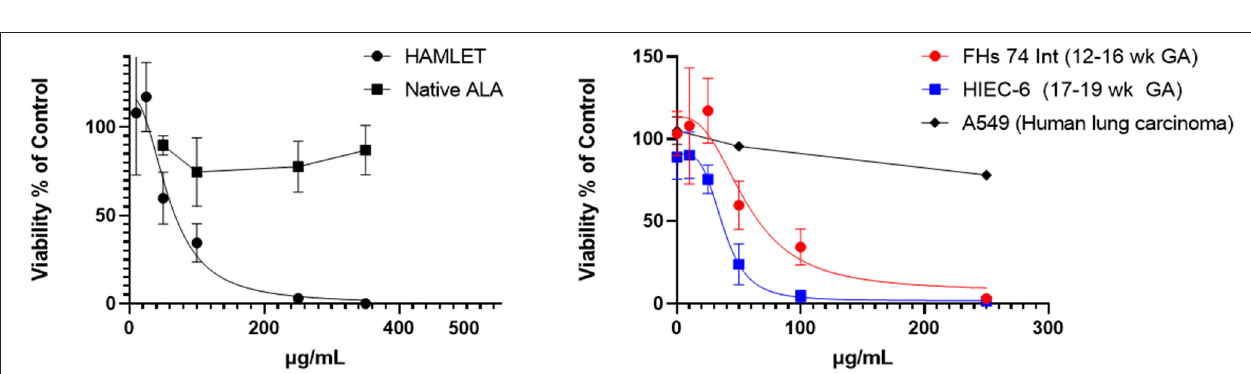
FIGURE 5 | Free oleic acid in casein vs. whey fractions in human milk. Milk ( n = 6) was skimmed, 1.0N HCl was added to adjust milk pH to 4.3. Acidified skimmed milk was centrifuged at 8000 × g for 10min to precipitate casein from whey layer. Separated proteins were pH corrected to 6.8 ± 0.1 pH in HBSS and analyzed for FFA content using UHPLC-MS/MS. GraphPad Prism calculated ANOVA tests with post-hoc Tukey multiple comparisons tests, significance p < 0.005***, p < 0.0001**** or NS (non-significant). HBSS, Hank’s buffered salt solution; FFA, free fatty acid; UHPLC-MS/MS, Ultra high performance liquid chromatography coupled with tandem mass spectrometry.